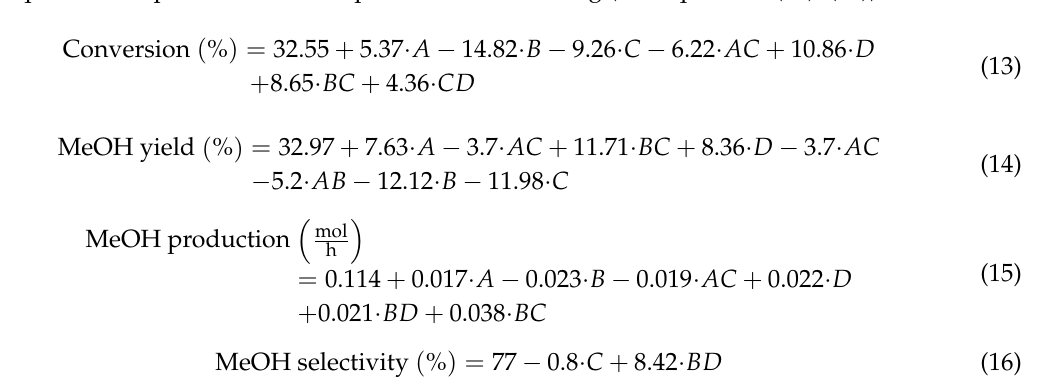
Figure 15. Methanol selectivity surface plots as function of analyzed factors (hold values: recycle 45%, temperature 240 ◦ C, water removal 40%, CO composition in the feed 10 mol%): ( a ) methanol selectivity as function of recycle and water removal; ( b ) methanol selectivity as function of temperature and water removal; ( c ) methanol selectivity as function of temperature and recycle; ( d ) methanol selectivity as function of CO composition in the feed and water removal; ( e ) methanol selectivity as function of CO composition in the feed and recycle; ( f ) methanol selectivity as function of temperature and CO composition in the feed.